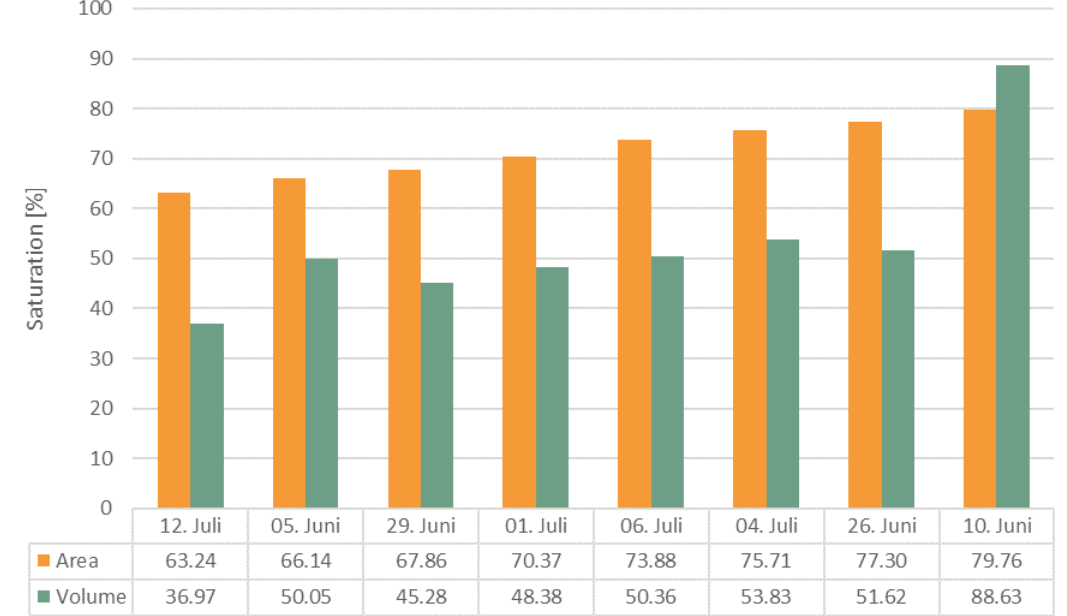
Figure 5. Exploitation of the floodplain area and volume capacity for chosen days of the simulated flood event in